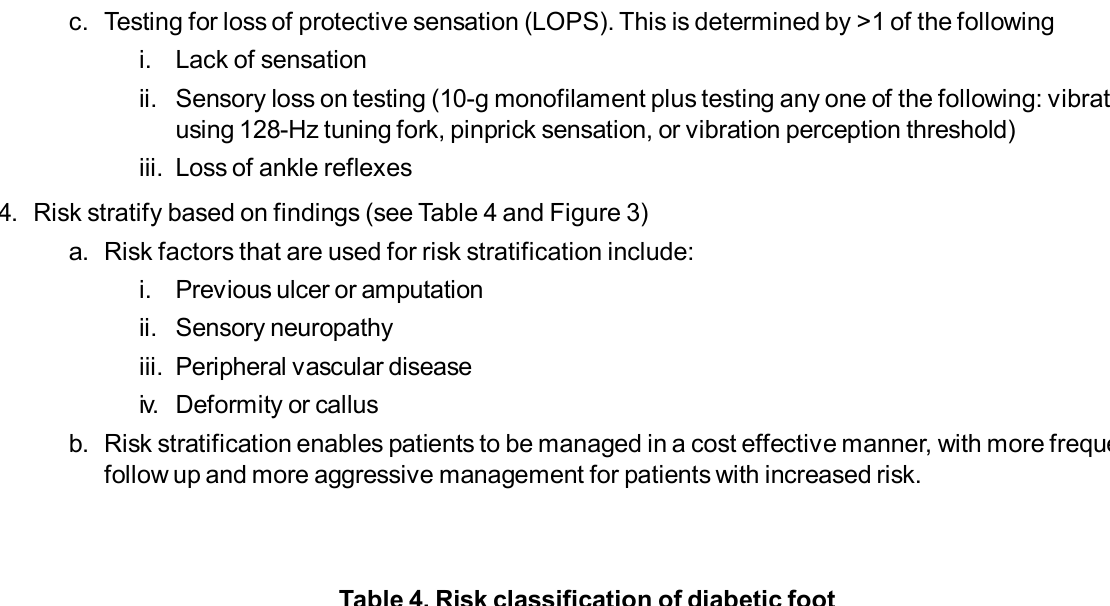
Table 4. Risk classification of diabetic